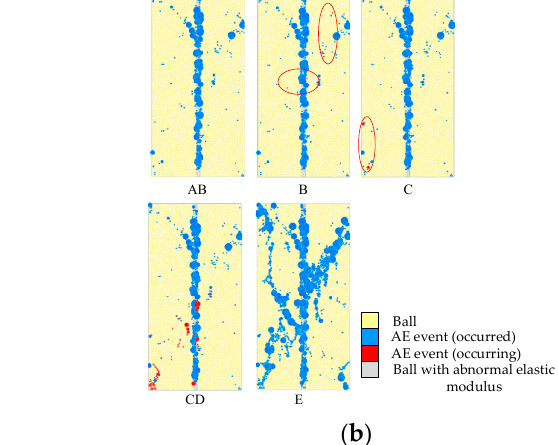
Figure 8. Numerical simulation results. ( a ) Stress and AE events of specimens with abnormal elastic modulus of 100 GPa; ( b )AE events distribution at different stages of the specimen.